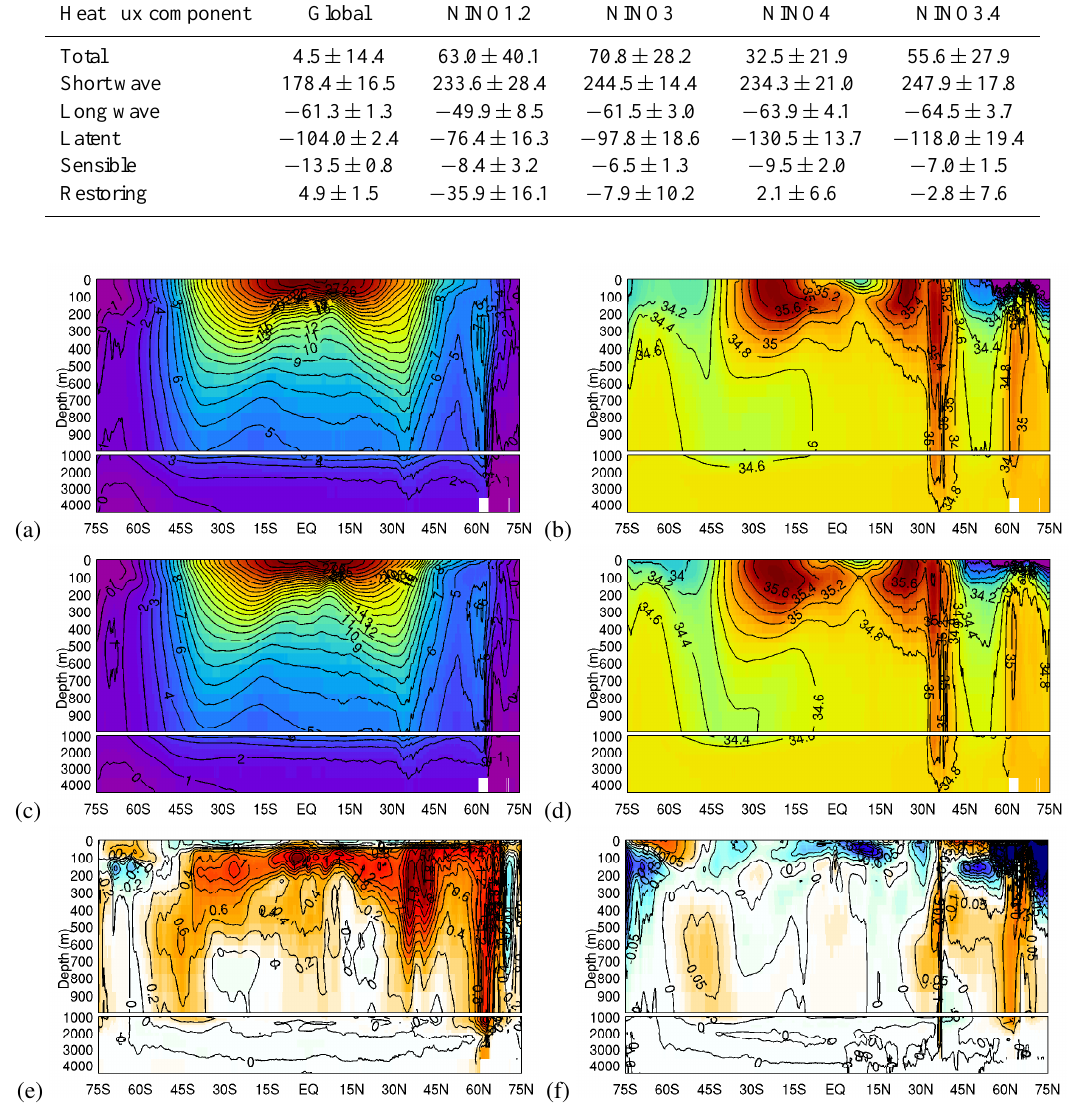
Fig. 4. (a, b) Modelled, (c, d) observed, and (e, f) modelled minus observed time and zonal mean (a, c, e) temperature and (b, d, f) salinity. The contour intervals for temperature are 1 ◦ C in (a, c, b) and 0.2 ◦ C in (e) . The contour interval for salinity is 0.2psu in (b, d) and 0.05psu Fig. 4. (a,b) Modelled, (c,d) observed, and (e,f) modelled minus observed time- and zonal-mean (a,c,e) temper- in (f) ature and (b,d,f) salinity. The contour intervals for temperature are 1 ◦ C in panels (acb) and 0.2 ◦ C in panel (e). The contour interval for salinity is 0.2 psu in panels (b,d) and 0.05 psu in panel (f).